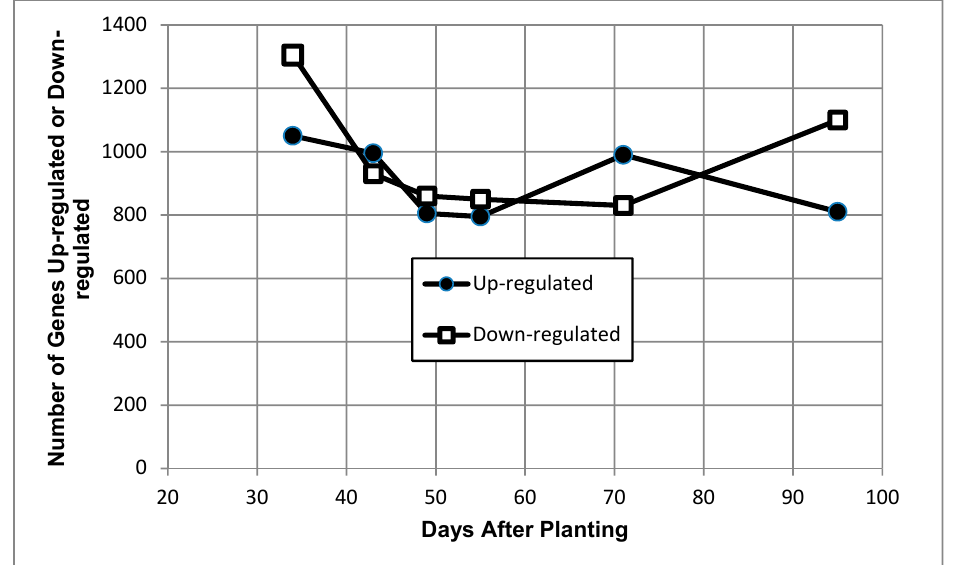
Figure 3. Number of up- and down-regulated genes of Bradyrhizobium diazoefficiens bacteroids as a function of days after planting. The transcripts included at each time point were determined independently of their values at other time points; thus, transcripts are typically included in multiple time points and may occur in either category. Solid symbols are up-regulated genes, and open symbols are down-regulated genes.